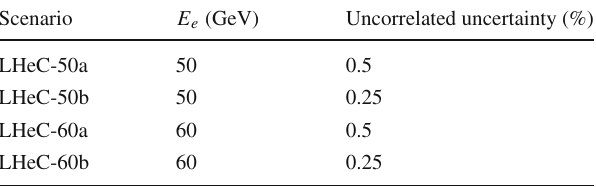
Table 3 Summary of the LHeC measurement scenarios. The LHeC data scenarios differ by the assumption on the electron beam energy, E e , and the assumptions made for the uncorrelated uncertainty (see text). They will be referred to by the names shown in the first